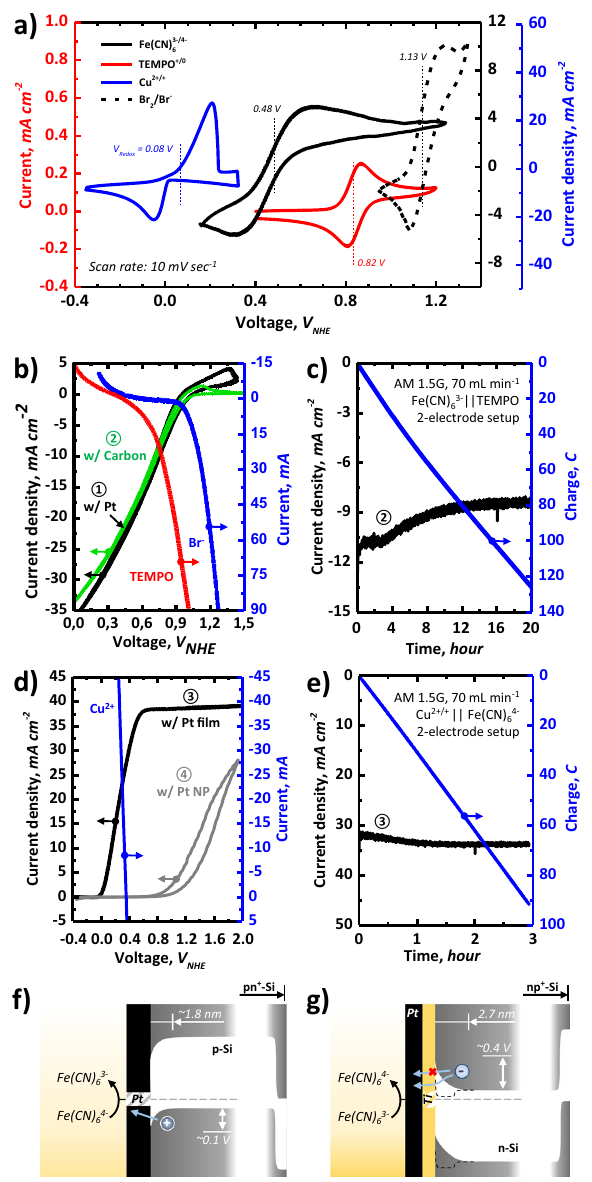
Fig. 4 CVs for redox couples and LSVs under illumination. a CVs of 2 mM solutions of TEMPO-sulphate, CuSO 4 , K 3 Fe(CN) 6 , and NH 4 Br using a scan rate of 10 mV sec − 1 . For the TEMPO-sulphate, K 3 Fe(CN) 6 and NH 4 Br, NH 4 Cl was used as a supporting electrolyte, and the pH was adjusted to 7. The pH of the Cu 2 + electrolyte was adjusted to 2 (with H 2 SO 4 ). b Overlaid